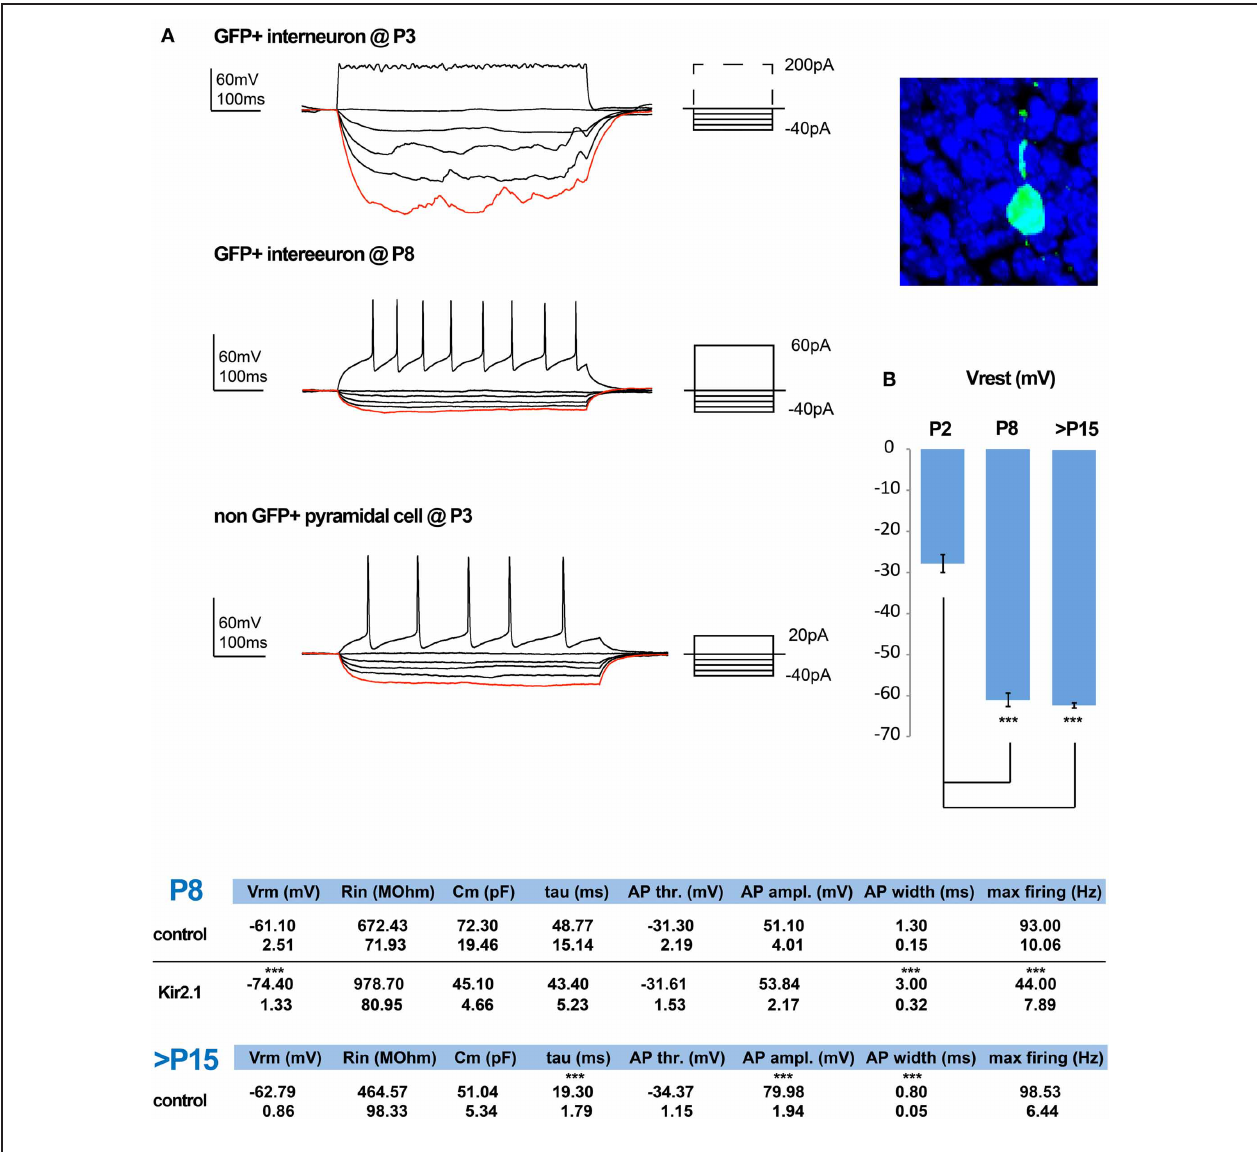
FIGURE 1 | Normal and activity-dependent developmental changes in the intrinsic electrophysiological properties of e15.5-born CGE-derived interneurons. (A) Examples of recordings from e15.5-electroporated GFP + interneurons within superficial layers at P3 (shown on the right) and P8. At P3 these neurons have a high input resistance (Rin) but lack the ability to generate action potential (AP) firing, even upon strong depolarization. In contrast, by P8 depolarization can induce APs and this is combined with a